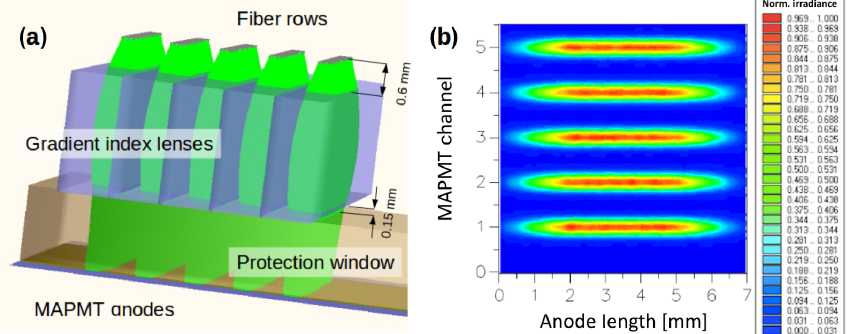
Figure 2. Optical engineering simulations of the redesigned fiber–MAPMT coupler used in the polar nephelometer part of PHIPS-HALO. Optical model (a) . Simulated irradiation in the plane of the anode slits of the multi-anode PMT (b) .